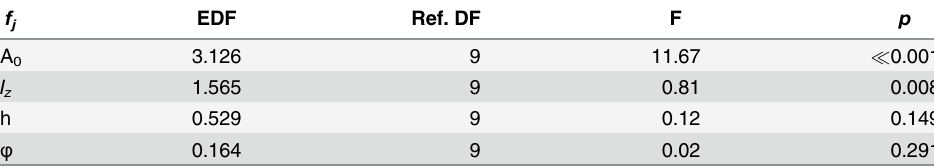
Table 1. Summary output from the fitted statistical model. Summary of the model used to describe the influence of surface area (A 0 ), the percent transmission per metre (I z ), altitude above sea level (h), and lati- tude ( φ ), as shown in Eq 3, on the diel surface temperature range. EDF is the effective degrees of freedom for the spline representing each covariate. Ref. DF is the reference degrees of freedom used in the statistical test of “ no effect ” for each smooth. F is the test statistic and p the approximate p -value of the test. I z is the percent transmission per